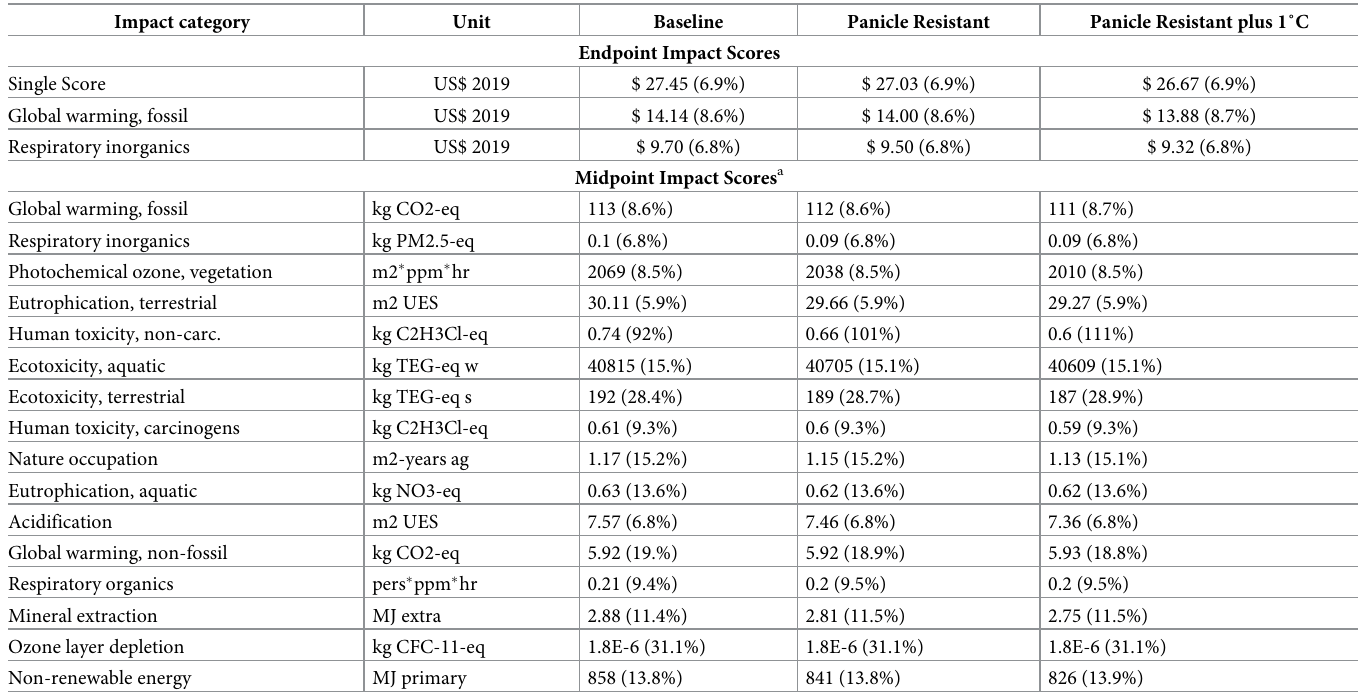
Table 5. Environmental impact scores using Stepwise LCA